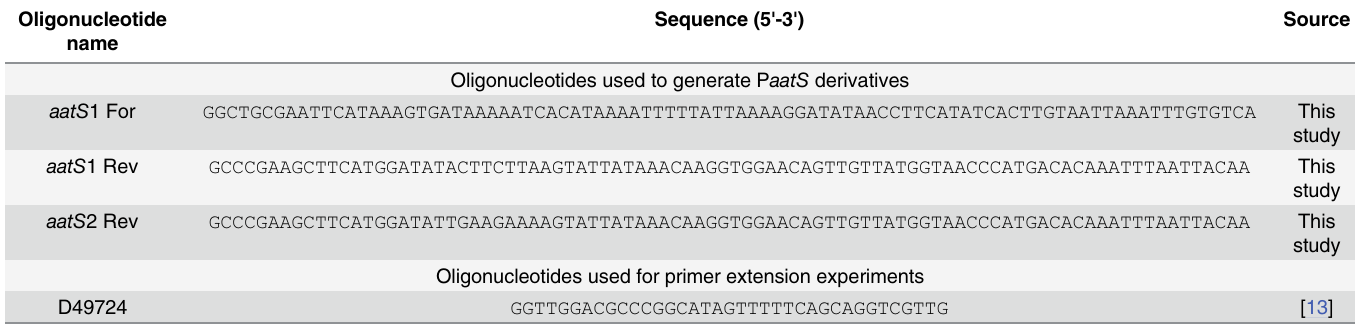
Table 2. Oligonucleotides used in this